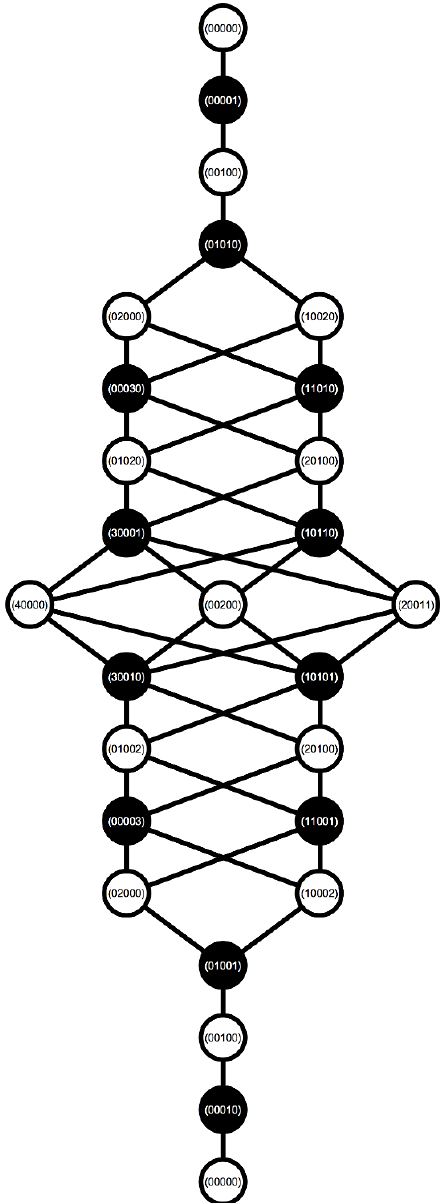
Figure 5 . Adinkra with dimensionality indi- cated in nodes.